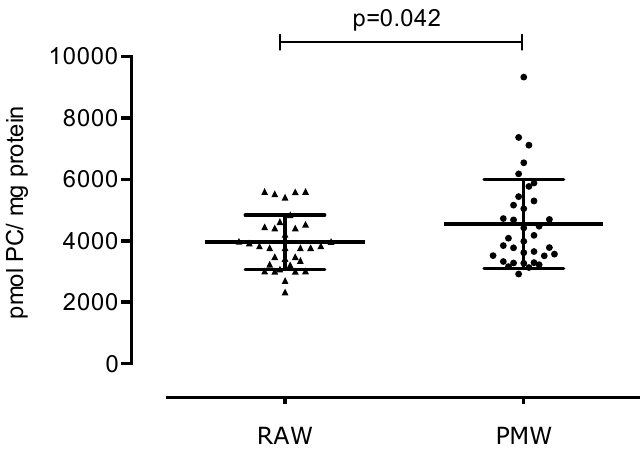
Figure 4. Marker of damage to proteins: Protein carbonylation in reproductive-aged women (RAW) and postmenopausal women (PMW).